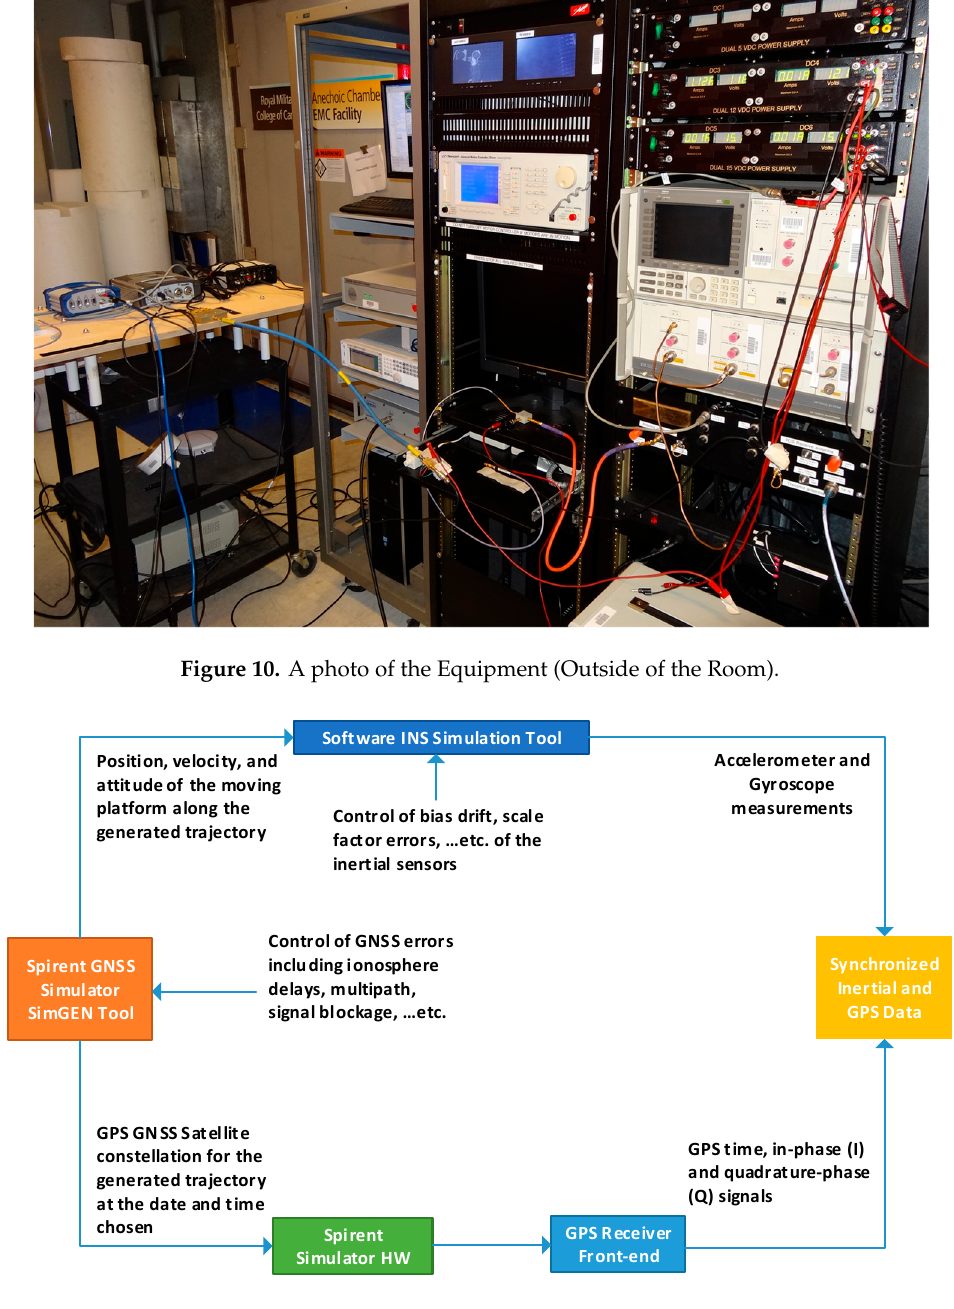
Figure 11. Data Simulation Tool Flow Diagram.